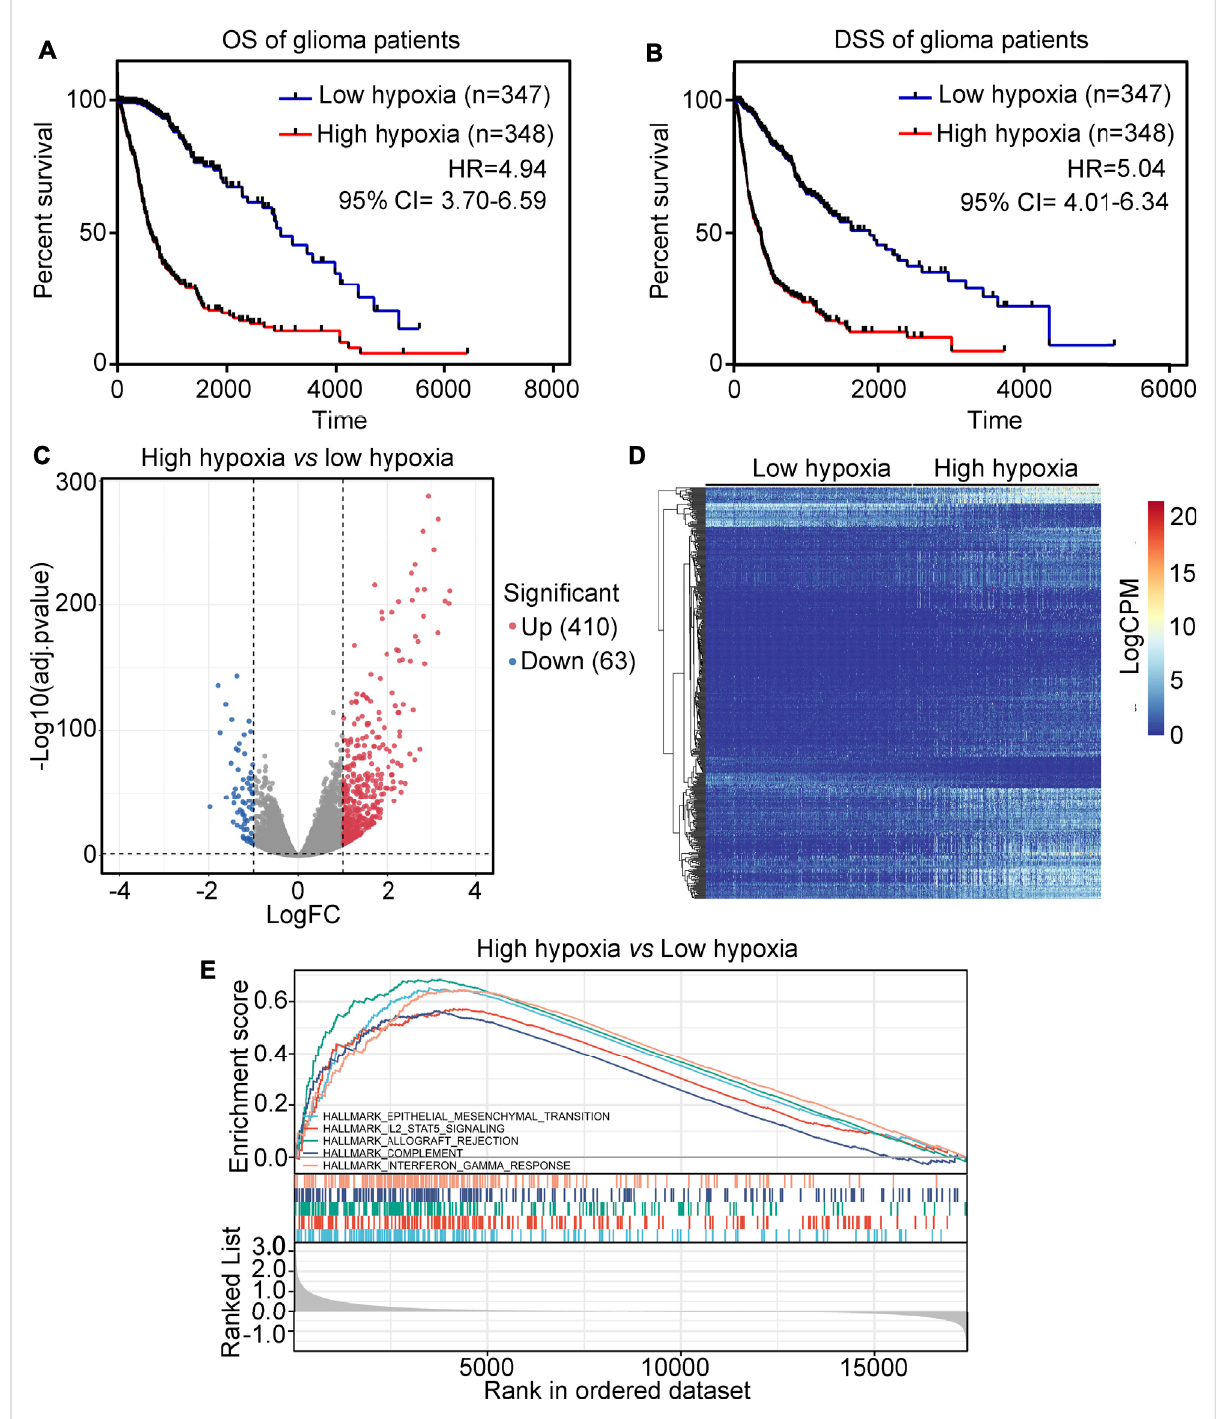
FIGURE 1 Analysis of the landscape between high-hypoxia and low-hypoxia glioma tissues. (A) The overall survival (OS) rate between high-hypoxia and low-hypoxia groups of glioma patients. (B) The disease-speci fi c survival (DSS) rate between high-hypoxia and low-hypoxia groups of glioma patients. (C) Volcano plot indicating DEGs between high-hypoxia and low-hypoxia groups of glioma tissues. (D) Heatmap indicating DEGs between high-hypoxiaandlow-hypoxiagroupofgliomatissues. (E) GSEAanalysisoftermsenrichedinDEGsbetweenthehigh-hypoxiaandlow-hypoxia groups of glioma